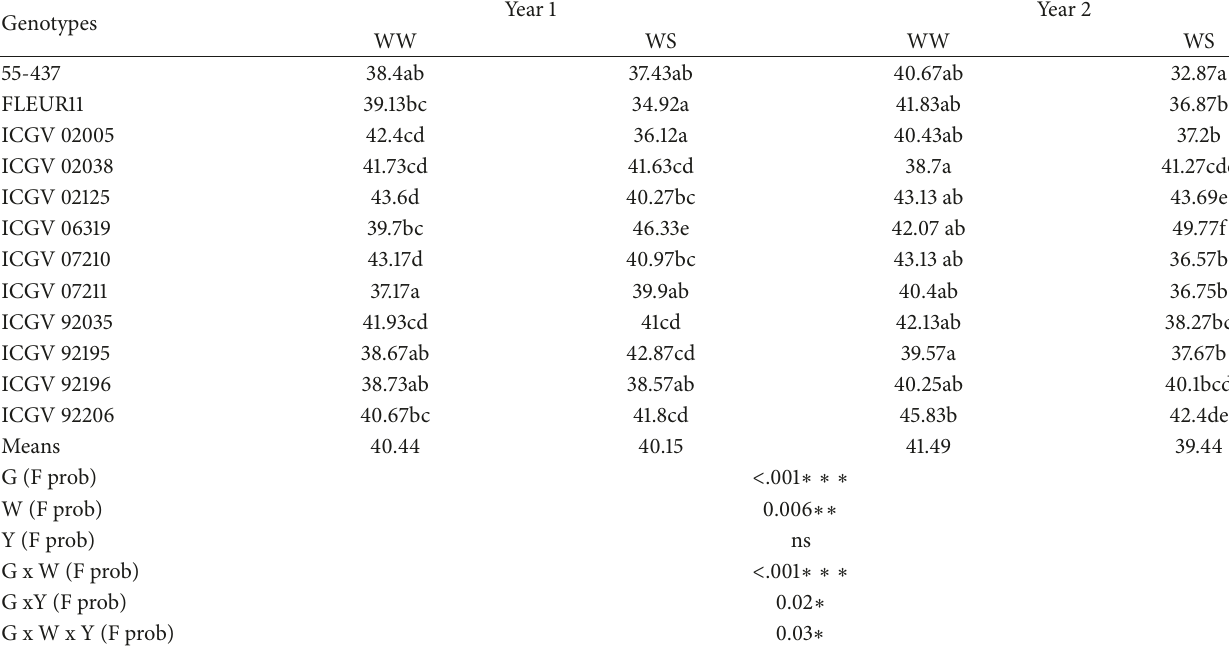
Table 2: SPAD Chlorophyll Meter Reading (SCMR) of groundnut genotypes in the well-watered (WW) and water-stressed (WS) treatments at 60 DAS in 2017 (year 1) and 2018 (year 2) in lysimeter experiment. G= genotypes, W = water regimes, and Y= year.